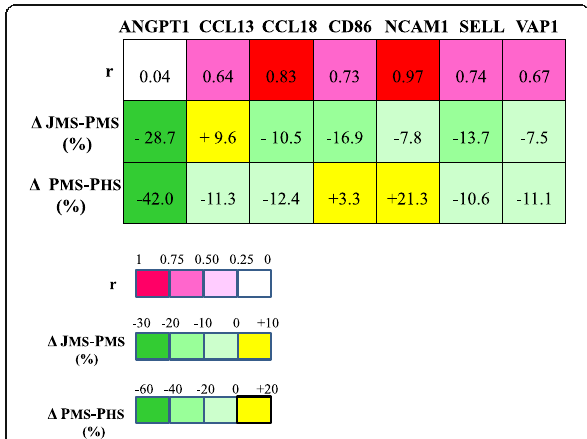
Fig. 2 Correlations and variations in protein plasma levels in the 1th MS population. r, Pearson coefficient of the correlation between jugular and peripheral plasma levels in MS patients. Δ JMS-PMS %,